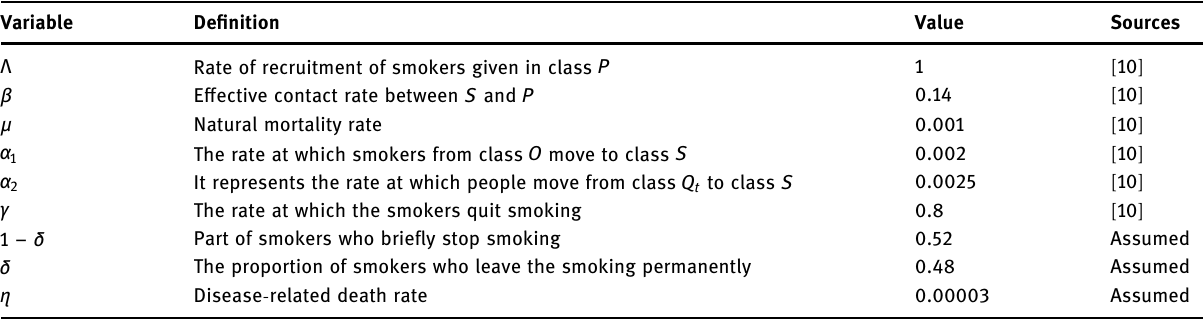
Table 1: Representation of values of parameters with sources